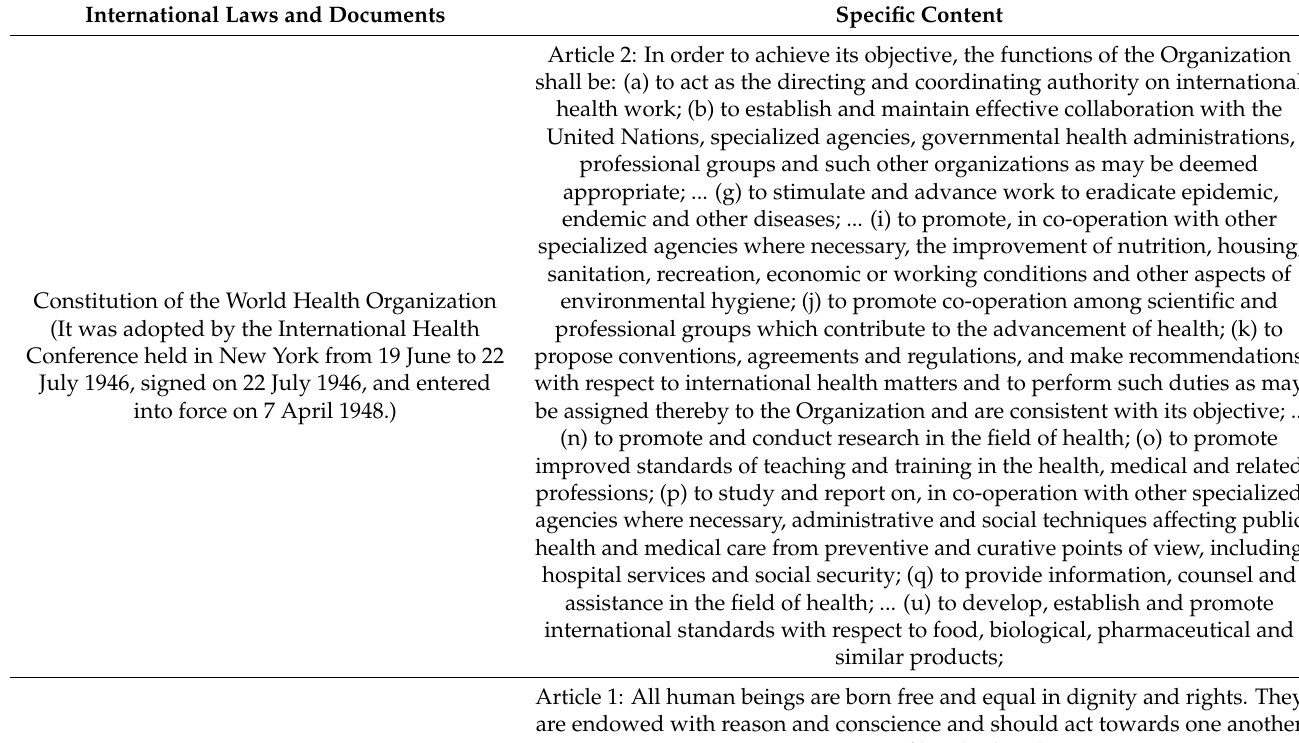
Table 2. Applicable international laws, non-binding measures, and policy frameworks to improve the vaccine production capacity in